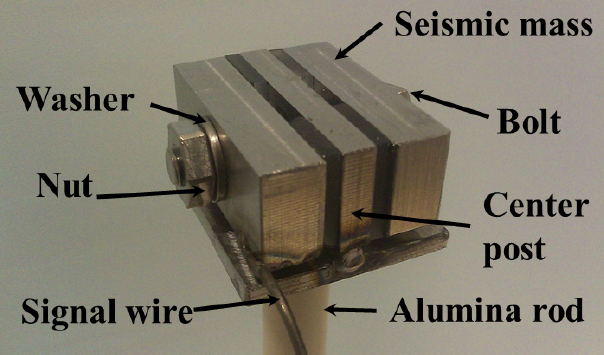
Figure 3. A photograph of the shear mode accelerometer assembly for high-temperature applications [58] (copyright 2012 by the